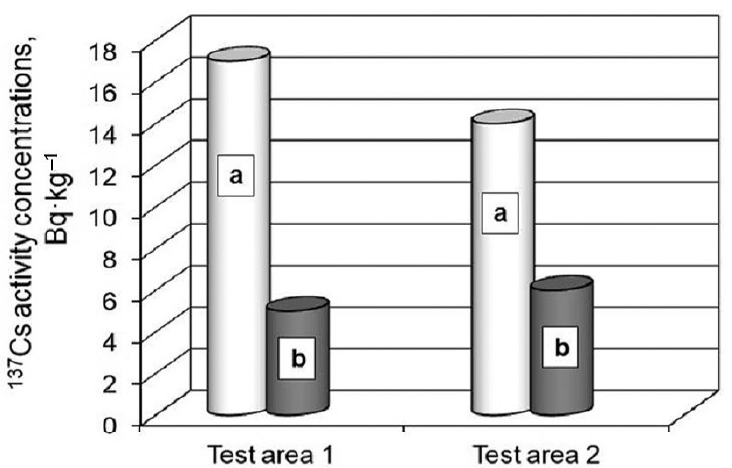
Figure 13. The 137 Cs activity concentrations in bottom sediments (d.w.) from the irrigation canal (a) and from the outlet canal (b) of test site 1 in the Krasnoperekopsky region and test site 2 in the Razdolnensky region of